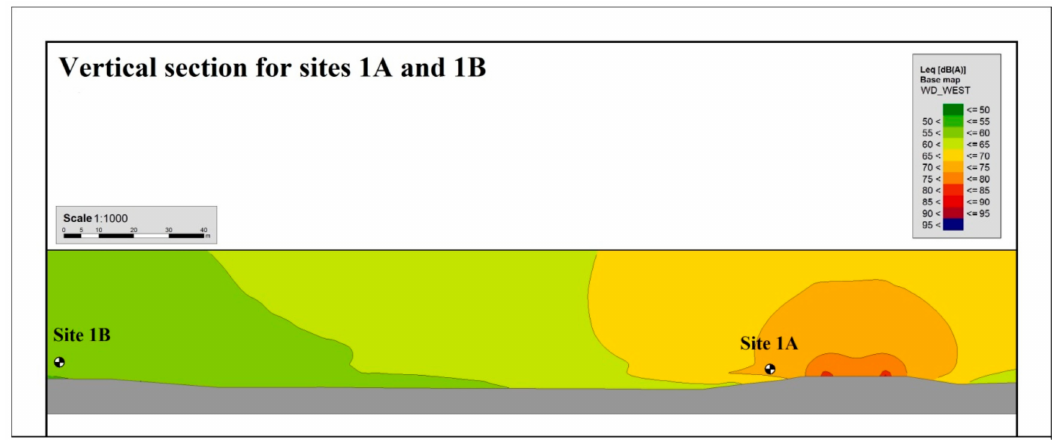
Figure 9. Terrain vertical section corresponding to sites 1A and 1B. Soil characteristics: uncultivated lawn, plain. Equivalent level intervals are displayed with di ff erent colors. Levels calculated according to the Basic Noise Map WD-WEST.